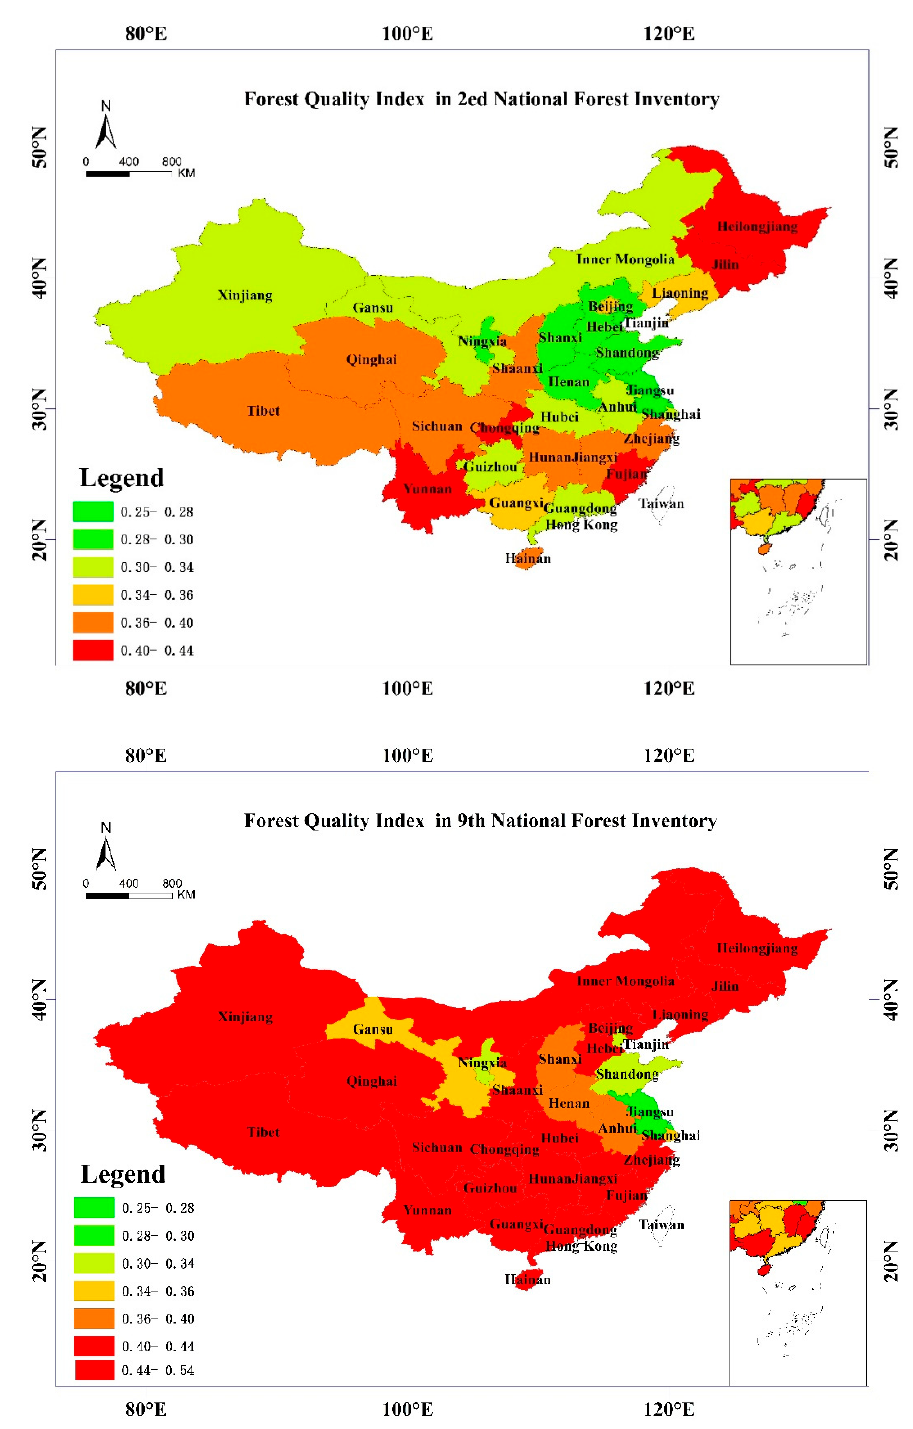
Figure 2. Forest quality index in 2nd and 9th National Forestry Inventory.